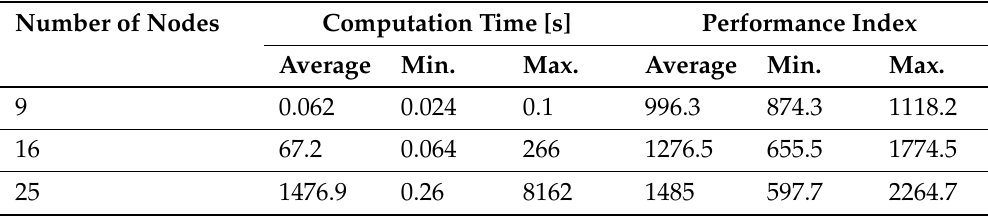
Table 6. Results for algorithm using total energy consumption index.